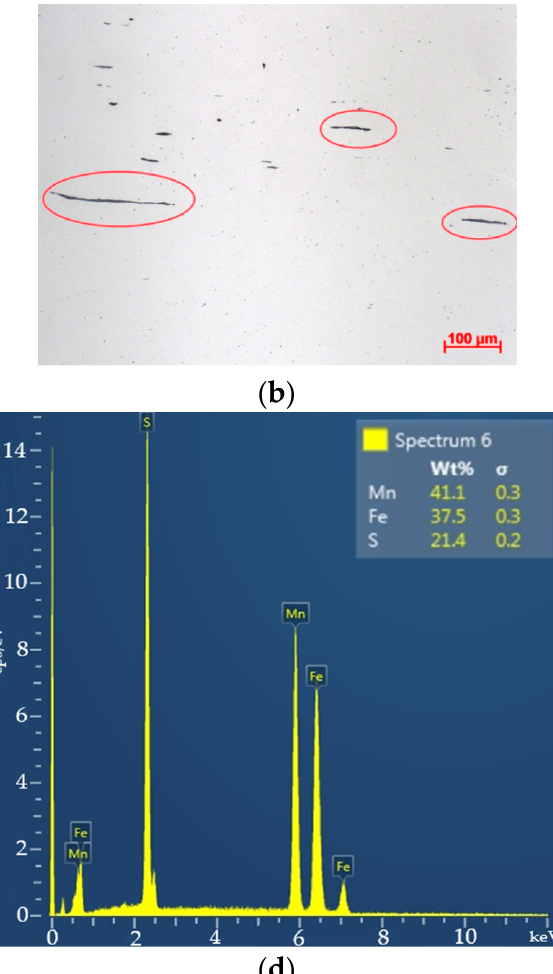
Figure 7. Distribution of AE hits amplitudes for a defect-free specimen at various load values 15 kN ( a ) 30 kN ( b ) 45 kN ( c ). When testing a specimen with a pre-grown crack, hits with an amplitude of up to 80 dB were recorded (Figure 8). Another difference from the data obtained when loading a